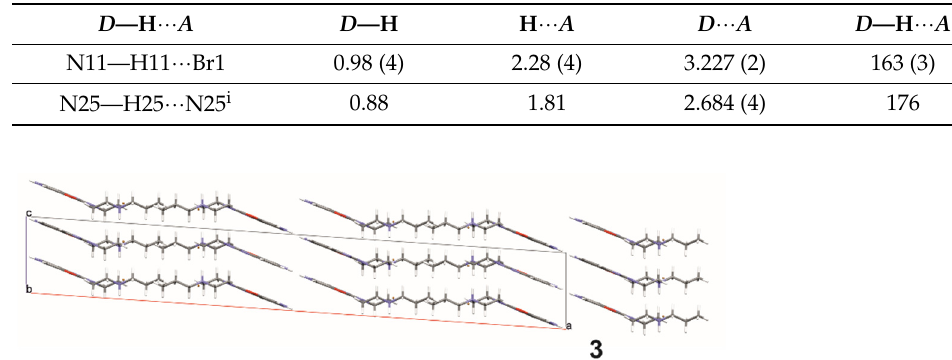
Figure 10. The intermolecular hydrogen bonds in compound 3 . Table 4. Strong hydrogen-bond geometry (Å, º) for 3. Symmetry codes: (i) − x +1, − y +1, − z +2.